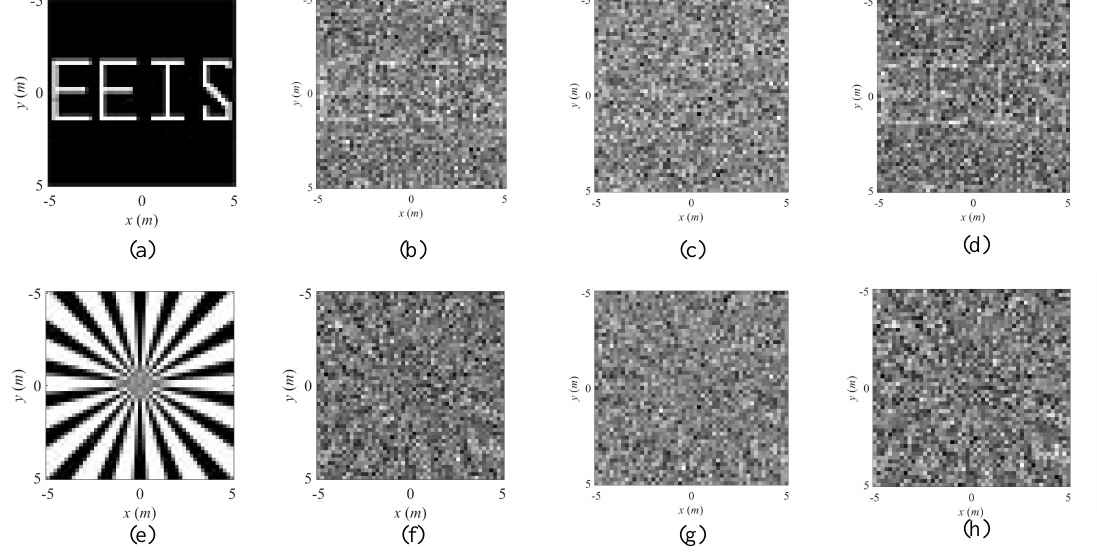
Figure 5. Imaging results of conventional MSCI and TD-MSCI. ( a , e ) is the imaging target. ( b , f ) is the result of conventional MSCI. ( c , g ) is the result of TD-MSCI without coherent integration. ( d , h ) is the result of TD-MSCI with echo enhancement.